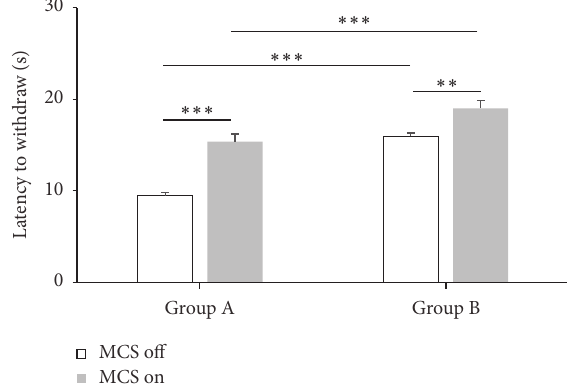
Figure 5: Overall changes of latency to withdrawal in Groups A and B with or without motor cortex stimulation (MCS). The latency increased with MCS on compared to MCS off in both Groups A and B which were statistically significant. During MCS off state, Group B showed longer latencies to withdrawal compared to Group A, which was statistically significant change. Also during MCS on state, latency increased in Group B with statistical significance [two- way analysis of variance (ANOVA) with Bonferroni post hoc tests; significant interaction between MCS and RAIC lesion factors 𝐹 = 5.081 , 𝑝 = .0336 ]. ∗∗∗ 𝑝 < .001 and ∗∗ 𝑝 < .01